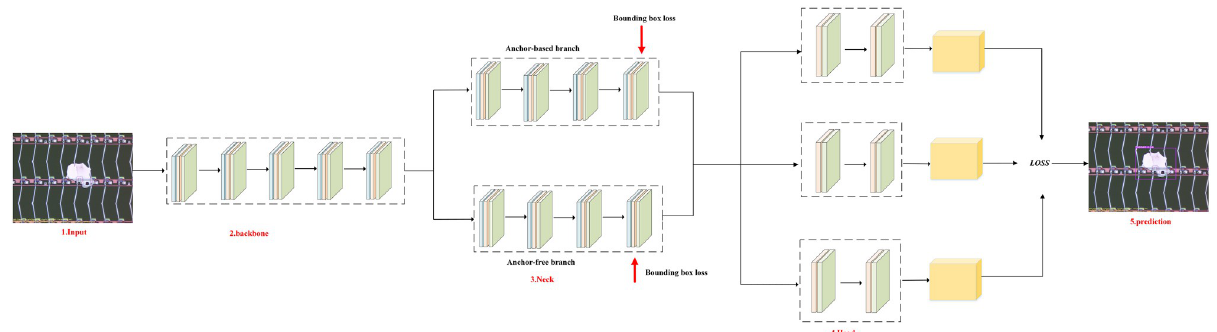
Fig 3. Overall network structure. Surface defect detector for electronic panels based on double branching and decoupling head structure. This includes backbone, neck which uses double branch for prediction box generation, and decoupled detection heads that incorporate attention mechanisms, including three large detection heads, each of which is decoupled into a classification detection head and a regression detection head. The details will be described in chapter 3.